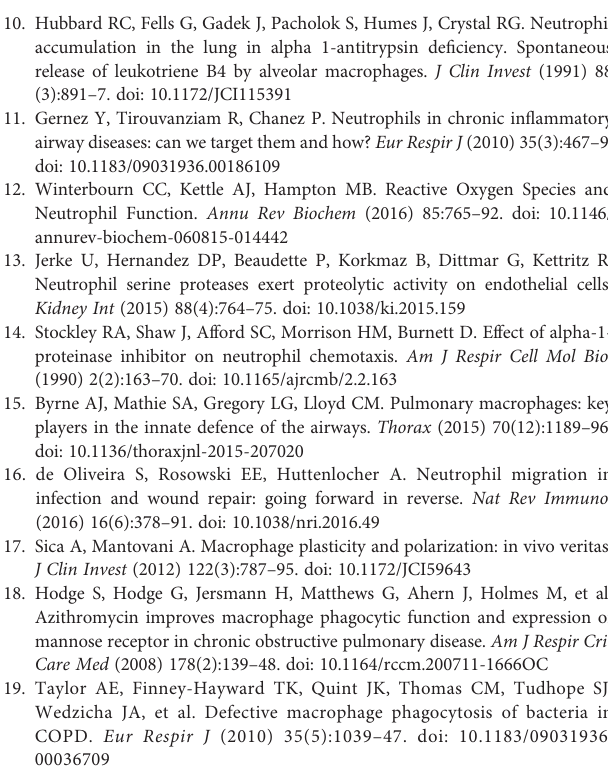
staining. SUPPLEMENTARY FIGURE 2 | Visualization of neutrophil efferocytosis by MDMs. M -MDMs were incubated with red color-labeled apoptotic neutrophils, and the images of phagocytizing MDMs were captured using fl uorescent microscope. (A – C) indicate the phase contrast of MDMs, red color-labeled apoptotic neutrophils, and MDMs phagocytizing apoptotic neutrophils, respectively. SUPPLEMENTARY FIGURE 3 | Calculation of neutrophil efferocytosis rate. Z-MDMs were incubated with apoptotic neutrophils in the absence or presence of LPS (10 ng/ml). (A, C) show control and LPS-treated cells that were gated on size and granularity, respectively. (B, D) show the percentage of control and LPS-treated MDMs phagocytozing apoptotic neutrophils, respectively. In the histogram plot, the fi rst peak indicates non-phagocytosing MDM population and the second peak indicates phagocytosing MDM population. SUPPLEMENTARY FIGURE 4 | Cell surface distribution of CD36 in MDMs. MDMswereincubatedintheabsenceorpresenceofLPS(10ng/ml)overnight.Blue and red fl uorescence indicates the nucleus and CD36, respectively. 63x Images were taken using a fl uorescence